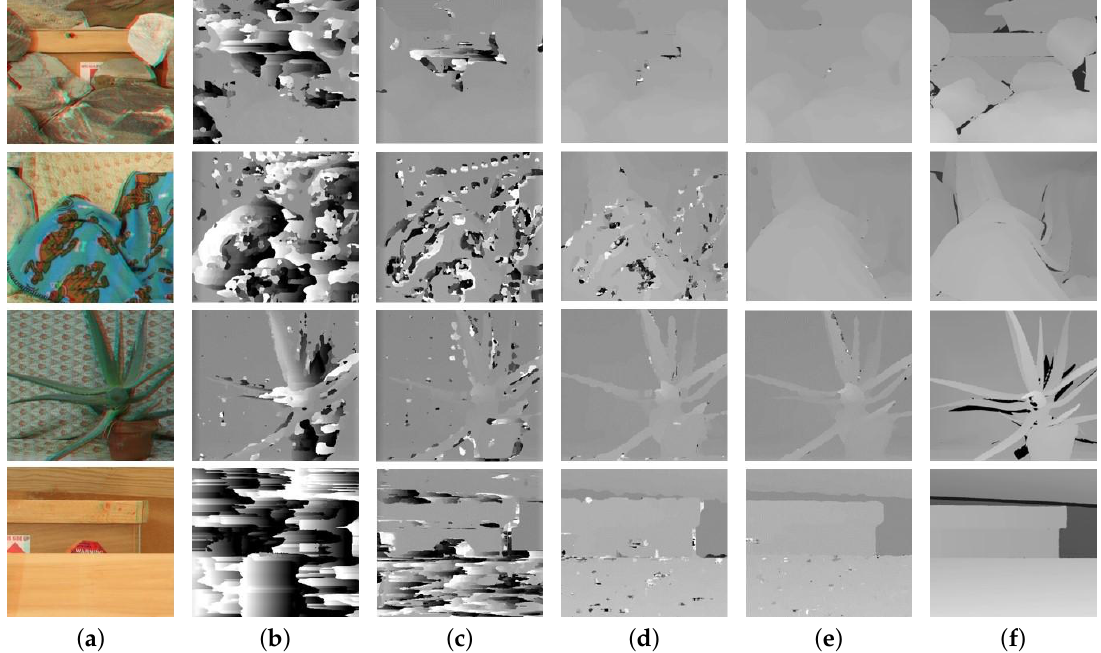
Figure 14. Disparity extraction of various matching methods with Middlebury stereo images ‘Rocks’, ‘Cloth’, ‘Aloe’ and ‘Wood’ [17]. ( a – f ) Input DCA image, disparity with SAD, NCC, Holloway’s CCNG, our method and the ground truth